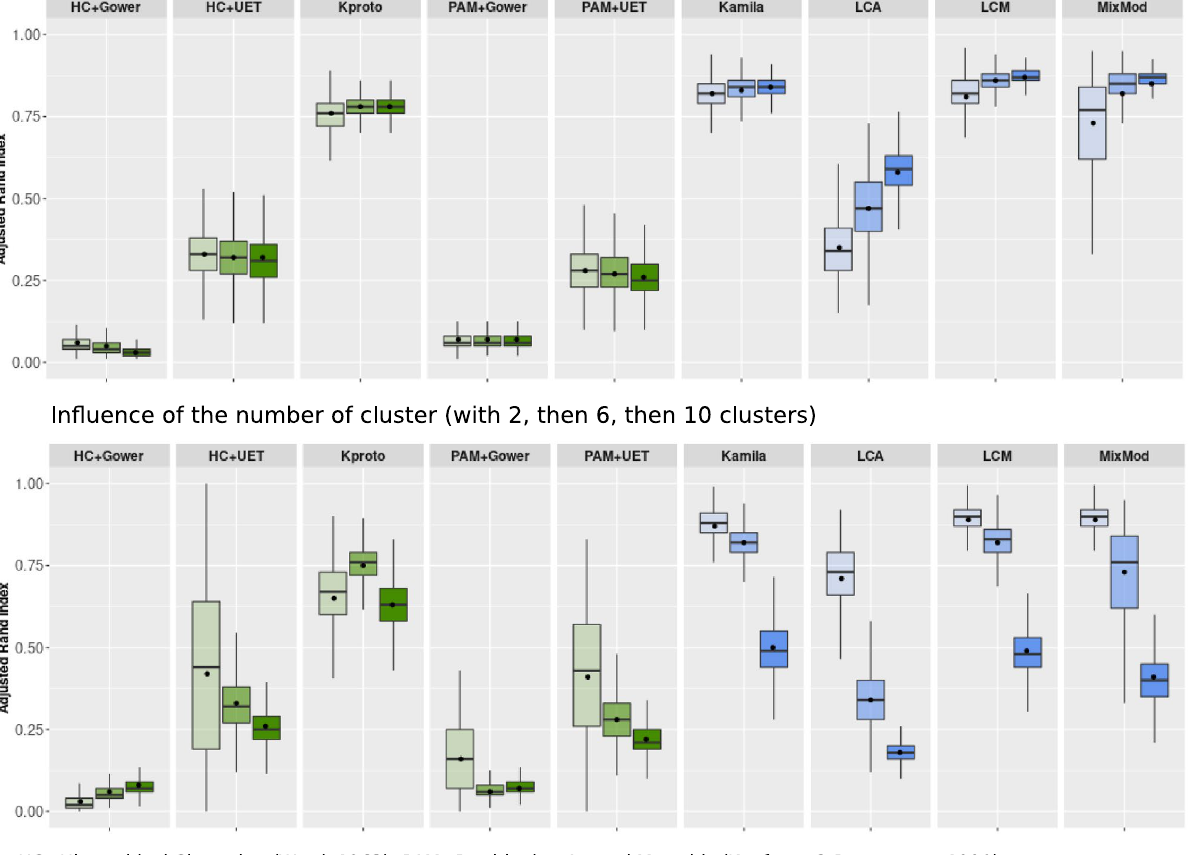
Figure 1. Influence of population size and number of clusters on clustering performance in simulation studies. This figure title was generated using R (R: A Language and Environment for Statistical Computing, R Core Team, R Foundation for Statistical Computing, Vienna, Austria, 2020, https ://www.R-proje